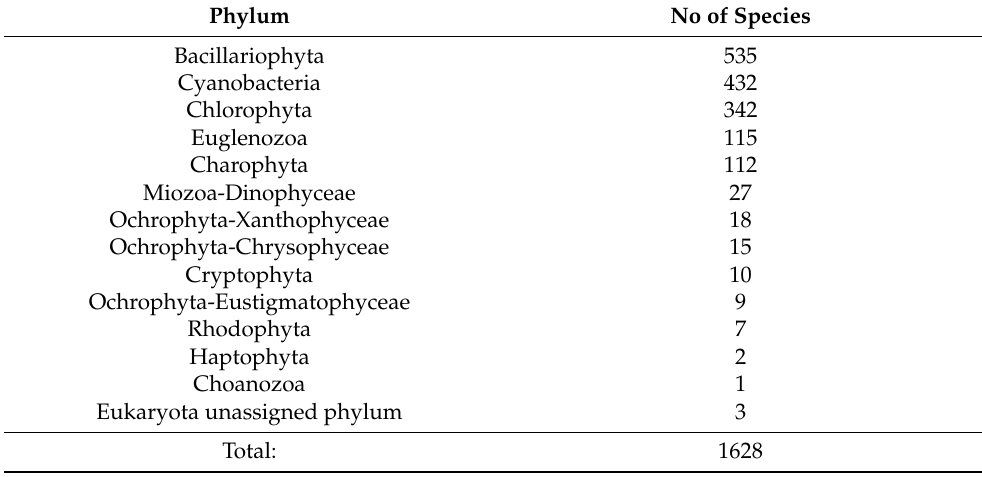
Table 1. Taxonomic content of algae and cyanobacteria flora in continental aquatic habitats of